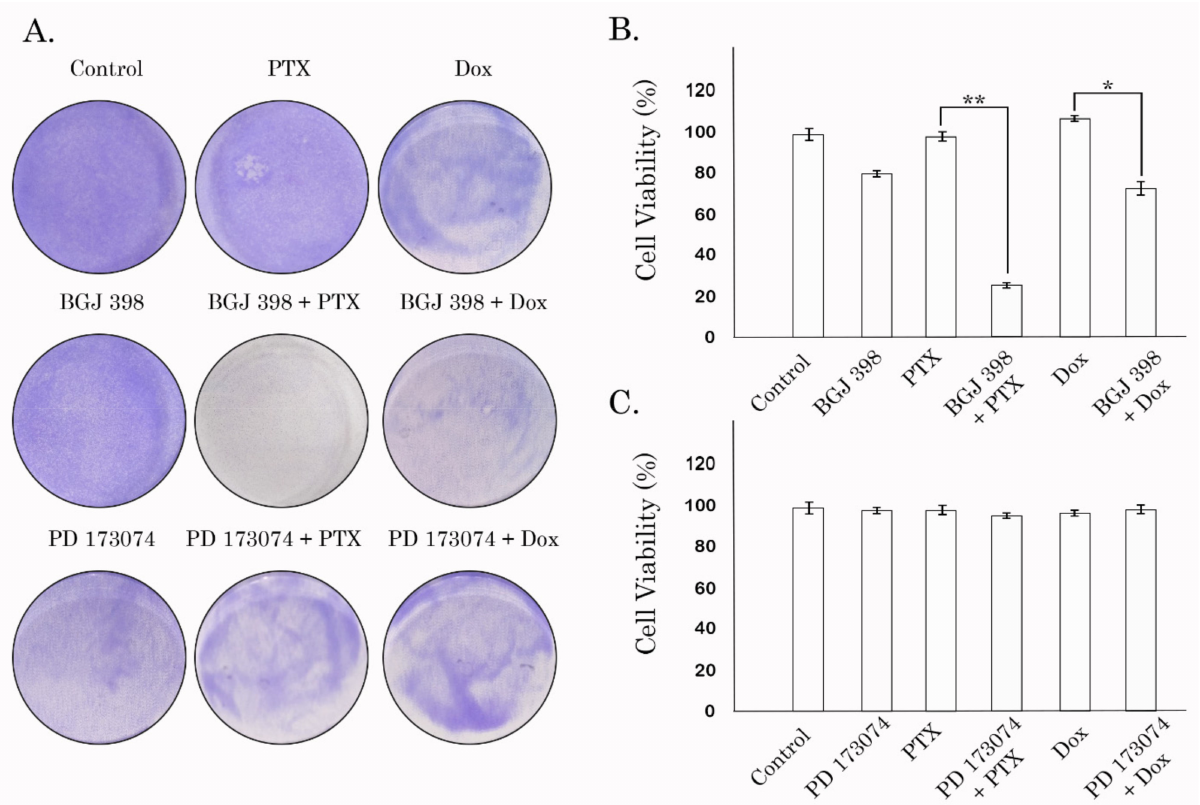
Figure 8. The impact of FGFR inhibitors (BGJ 398 and PD 173074) used in combination with PTX or Dox on proliferation and survival of Tx-R HCC 1806 breast cancer cells; ( A ) Crystal violet staining of Tx-R HCC 1806 cells that were treated with BGJ 398 (or PD 173074) alone or in combination with PTX (or Dox) for 96 h. The cells treated with DMSO were used as a control. The cells treated with PTX or Dox alone illustrated chemoresistance of Tx-R HCC 1806 cells. The culture dishes were fixed with ice-cold 100% methanol, stained with crystal violet, and photographed; ( B ) Quantification of crystal violet staining of Tx-R HCC 1806 cells treated with PTX and Dox alone or in combination with BGJ 398. The plates were dried, crystal violet was dissolved using 0.1% SDS solution, and absorbance was measured at 590 nm. The graphs represent the mean ± SD. * p < 0.05; ** p < 0.01; ( C ) Quantification of crystal violet staining of Tx-R HCC 1806 cells treated with PTX and Dox alone or in combination with PD